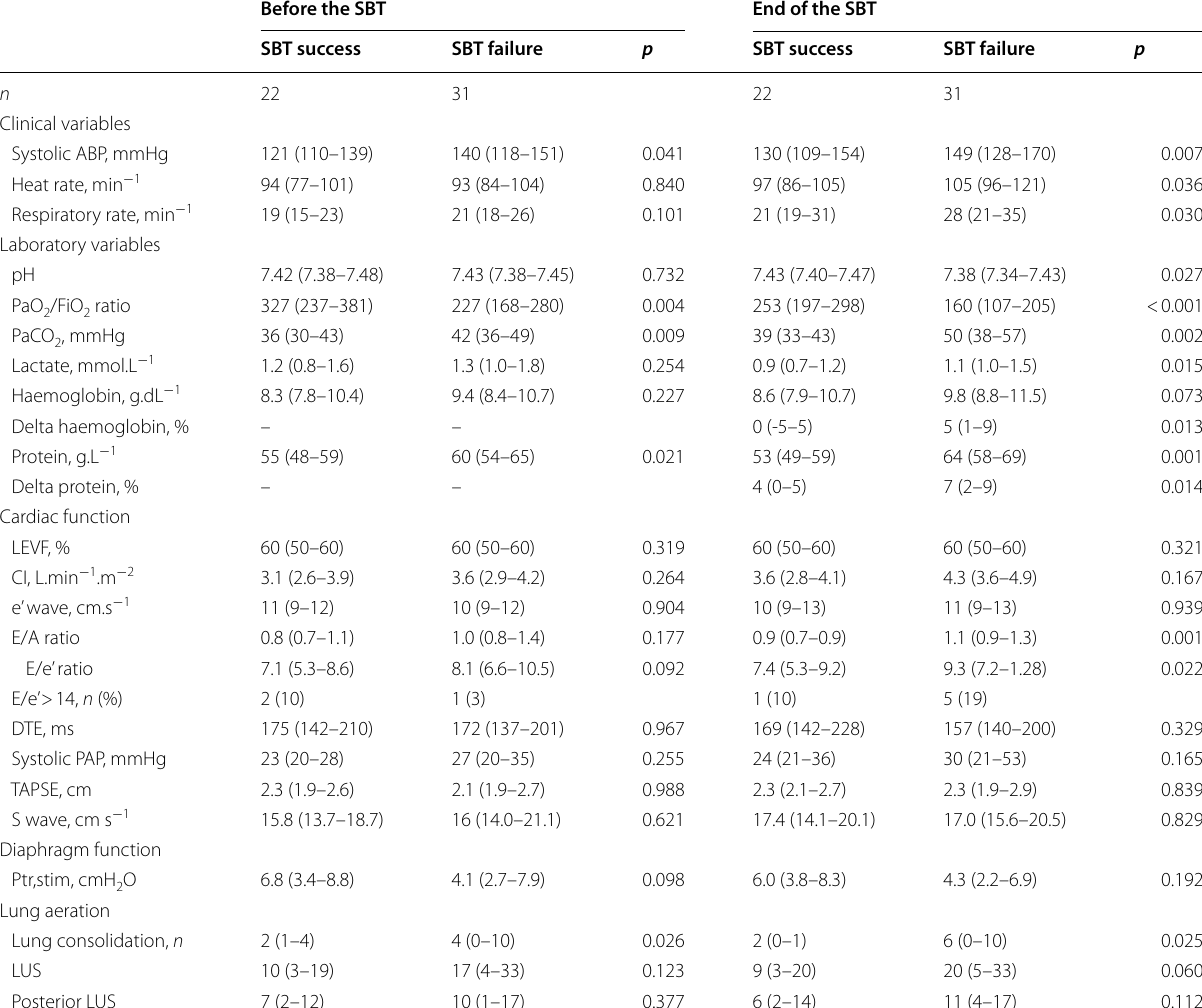
Table 2 Clinical variables, gas exchange, cardiac function and lung aeration before and at the end of the spontaneous breathing trial